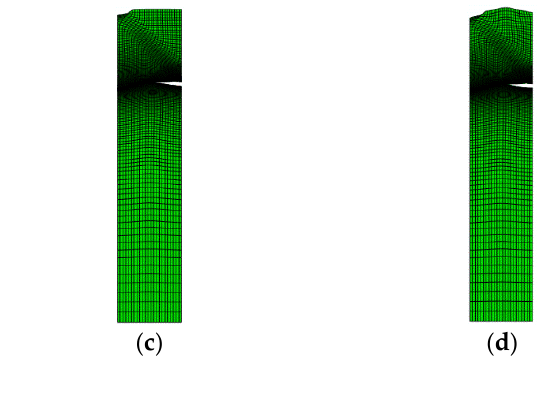
( h ) Figure 8. Failure mode of the laminate for two different wavelengths of ( a – d ) h/2 and ( e – h ) 2 h, ( a , e ) without roughness, ( b , f ) roughness on Al foil surface, ( c , g ) roughness on LDPE surface and ( d , h ) roughness on both layers. 3.2. The Influence of Different Interfacial Properties This section investigates the influence of interfacial properties without imperfections (surface roughness). To study the effect of interface properties on the laminate behavior, different values for traction and separation are defined as listed in Table 5. Logically, the initial stiffness will change accordingly by changing the traction and separation values. Table 5. Sequence of change in maximum traction and the final separation. Maximum Traction Ratio ( 𝝈 𝒑 /𝝈 𝑨𝒍𝒀 ) ( − ) Separation Ratio ( 𝜹 𝒑 /𝒉 ) ( − ) 0.01 0.01 1 1 100 100 The overall behavior of the material with different traction and separation values is provided in Figure 9. The results emphasize that a change in traction leads to different behavior, particularly in the softening branch, such that the higher traction retards the Al degradation, and by reducing the traction, the maximum stress reduces as well. By increasing the separation quantities ( 𝛿 (cid:3043) /ℎ ) from 0.01 to 100, the results highlight that if the separation is low, adopting high quantities for traction leads to the same behav- ior, while for higher separation, the laminate behavior is almost unaffected by lower trac- tions. The primary function of LDPE connected to a thin Al foil is to improve the Al foil’s final elongation. In order to attain this goal in a real-world application, the interfacial layer properties should be adjusted to have weak separation and medium traction properties.